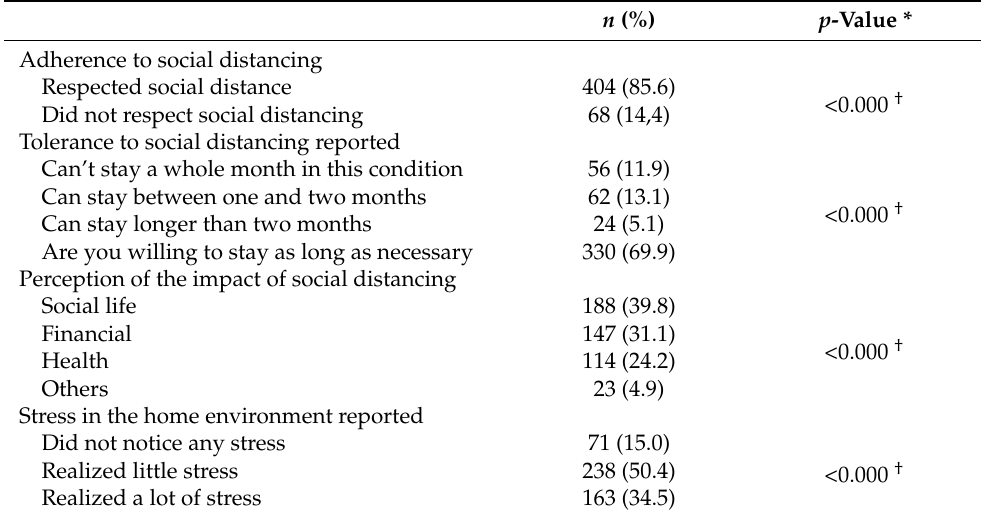
Table 3. Characterization of the social isolation of individuals with type 1 diabetes during the COVID-19 pandemic in Brazil.